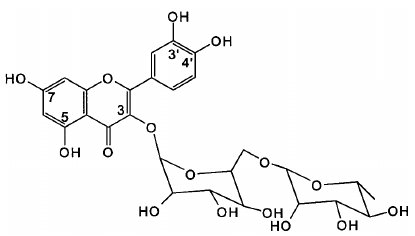
Figure 2. Structure of quercetin-3- O -rutinoside (rutin): quercetin commonly occurs conjugated with a sugar moiety at the 5, 7, 3 (cid:48) , 4 (cid:48) or 5 (cid:48)